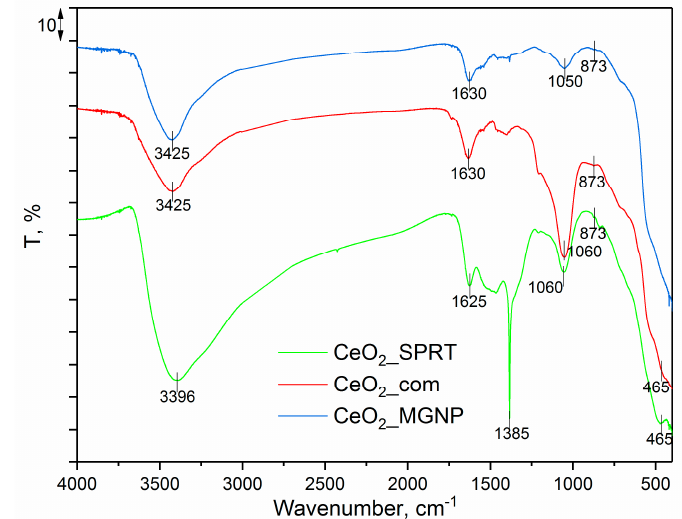
Figure 5. FTIR spectra of the CeO 2 _com, CeO 2 _MGNP, and CeO 2 _SPRT samples. MGNP: modified glycine nitrate procedure, SPRT: self-propagating reaction at room temperature.